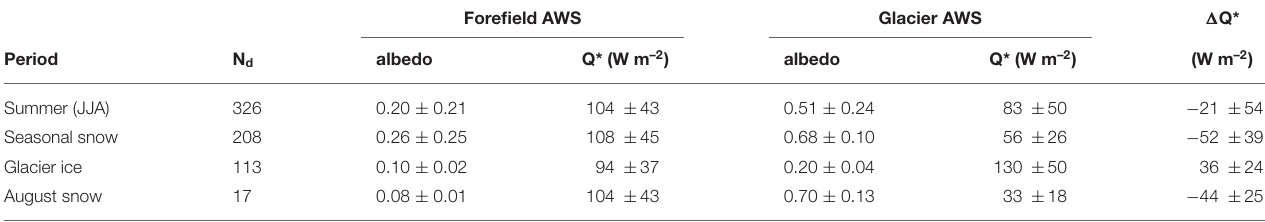
TABLE 2 | Mean daily albedo and net radiation, Q * , recorded at the glacier and off-glacier automatic weather stations on Kwadacha Glacier, 2008–2011. Forefield